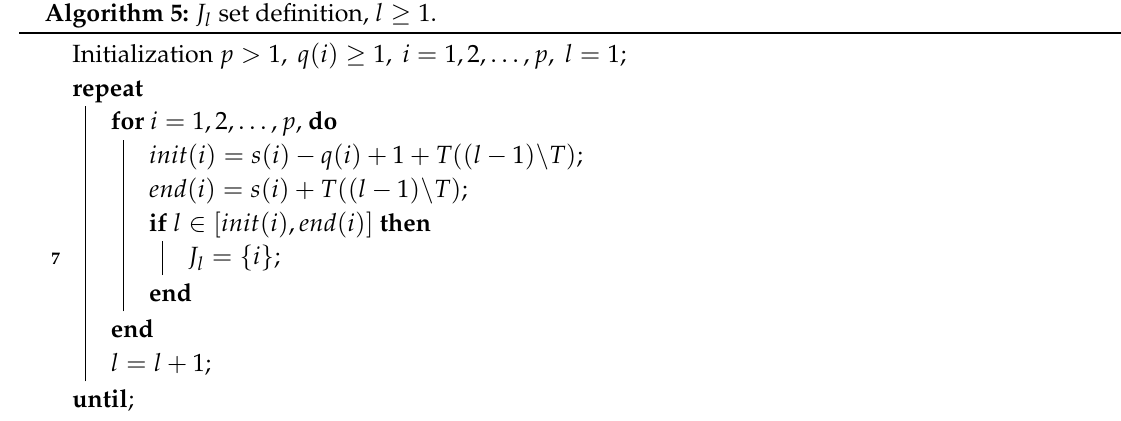
Algorithm 5: J l set definition, l ≥